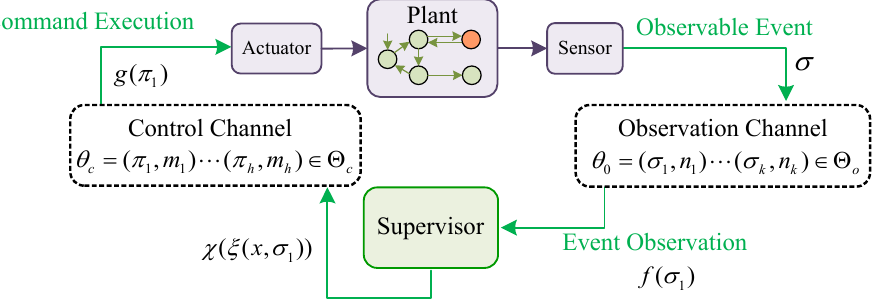
Figure 3. The interaction process between the plant and the